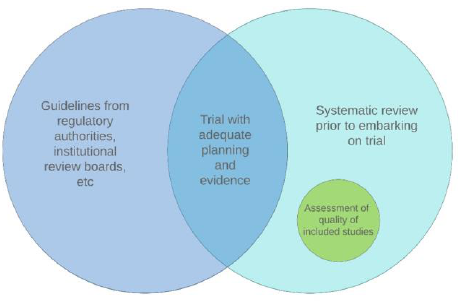
Figure 7. Our recommendations for evidence gathering prior to the start of a biomarker-guided trial, based on the findings of this review.